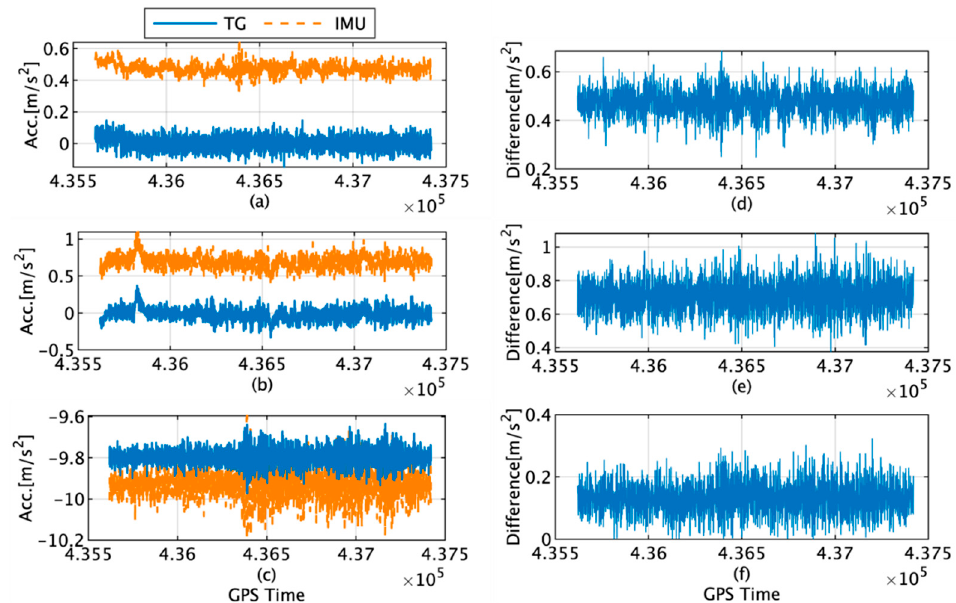
Figure 8. ( a ) Acceleration along x -axis acceleration of the IMU (orange) and TG (blue); ( b ) y -axis acceleration of the IMU (orange) and TG (blue); ( c ) z -axis acceleration of the IMU (orange) and TG (blue); ( d ) difference in x -axis acceleration between the IMU and TG; ( e ) difference in y -axis acceleration between the IMU and TG; ( f ) difference in z -axis angular velocity between the IMU and TG.